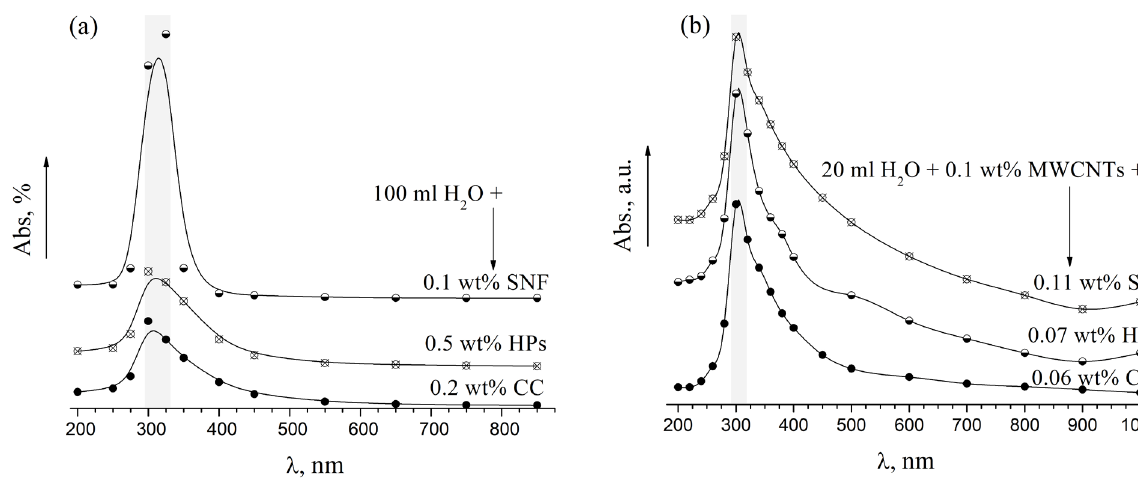
Figure 5. The optical absorption spectra of: (a) [H